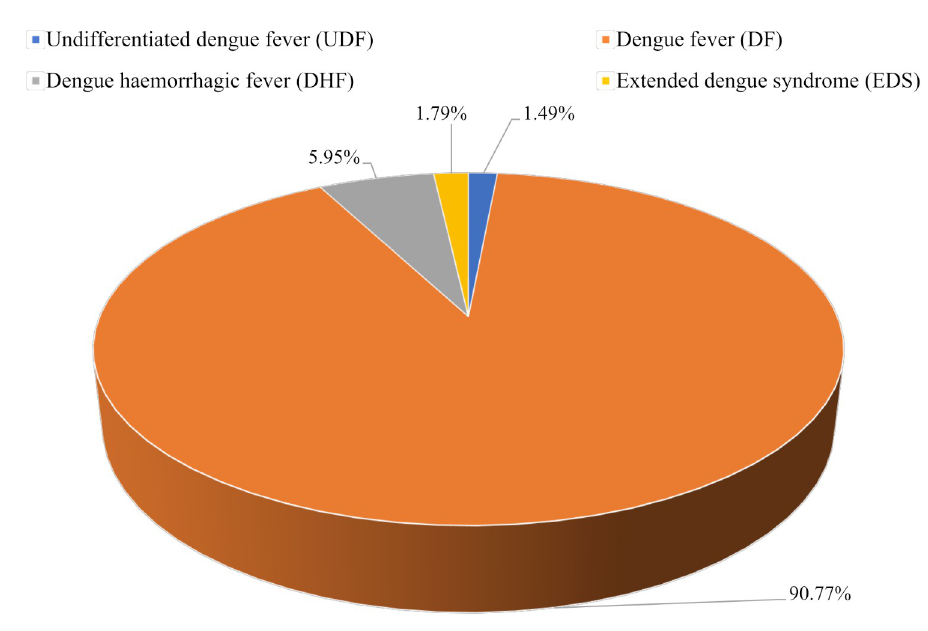
Fig 1. Distribution of dengue cases by severity among study